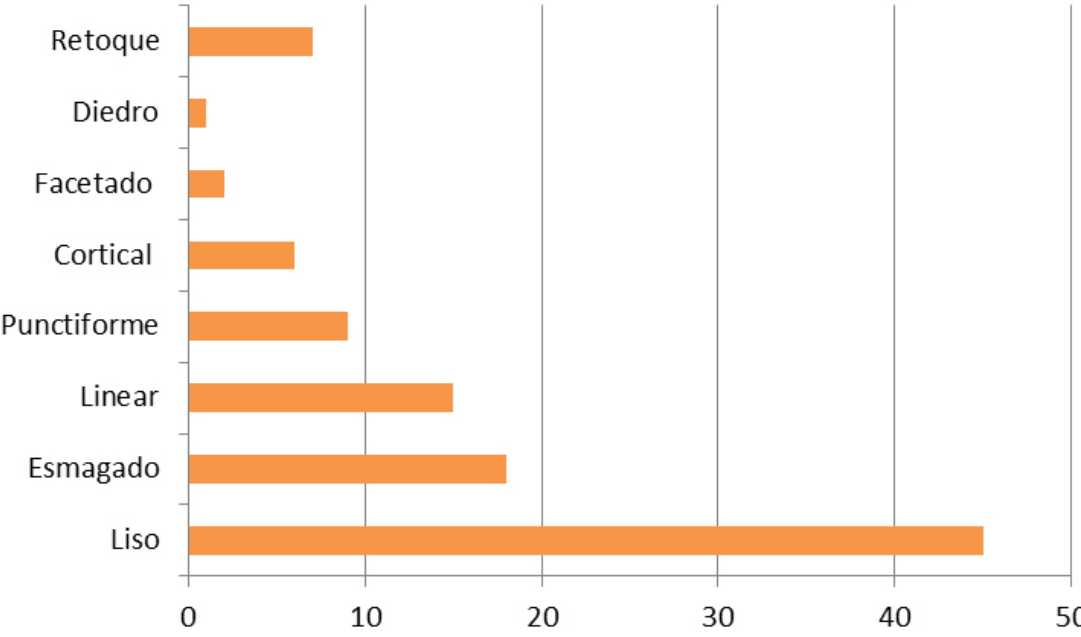
Figura 3. Magdalenense antigo: tipos de talão identificados no conjunto lítico do nível inferior do Cabeço de Porto Marinho I. Figure 3. Ancient Magdalenian: butt types identified in the lithic assemblage of the lower level of Cabeço de Porto Marinho